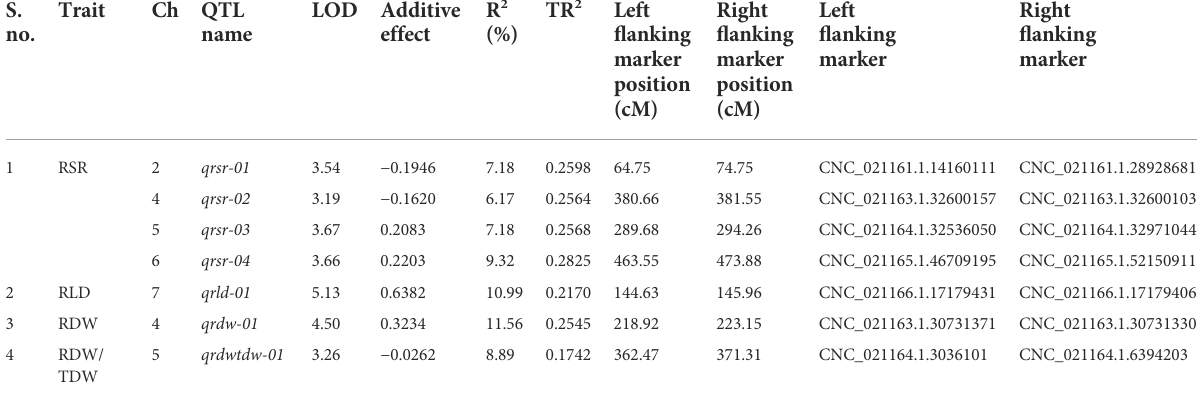
TABLE 7 Summary of QTLs associated with the identi fi ed root-related traits under drought stress. S. no.